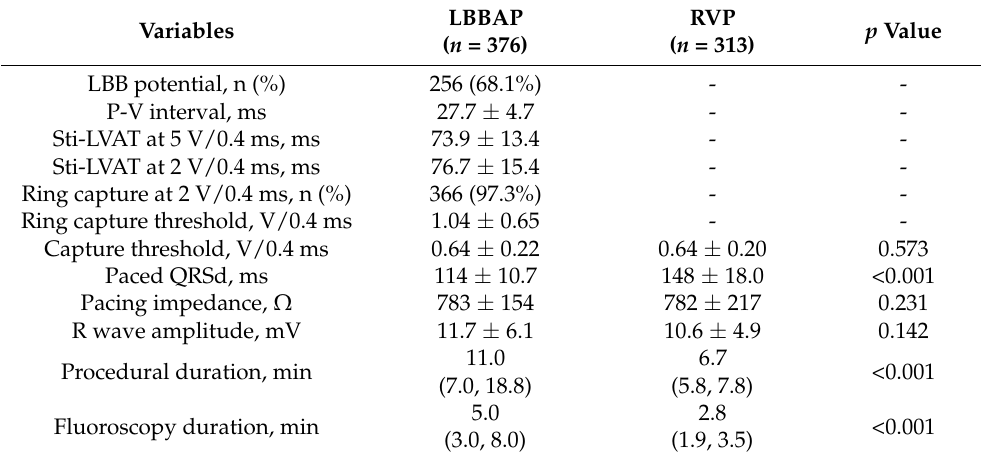
Table 2. Comparison of pacing and procedural parameters in LBBAP and RVP